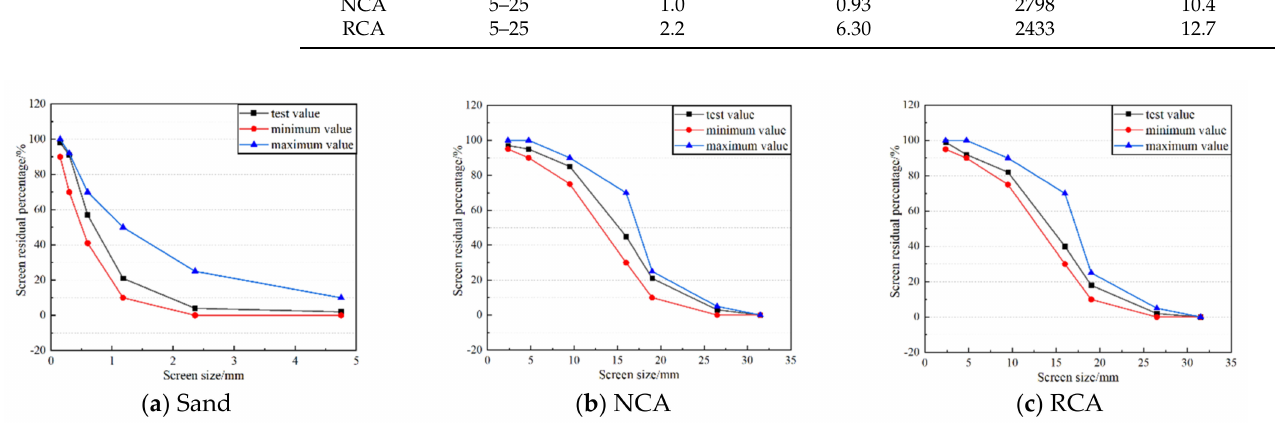
Figure 1. The grading curves of the